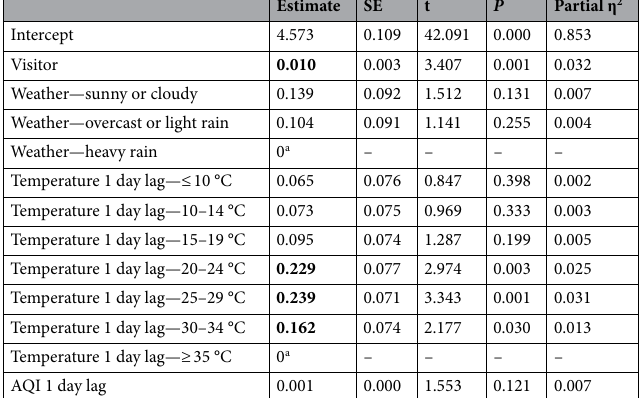
Table 2. The one day lag regression model exploring air pollution effects on social conflict (Ln) of monkeys in Nanjing Hongshan Zoo in China. a This parameter is set to zero because it is